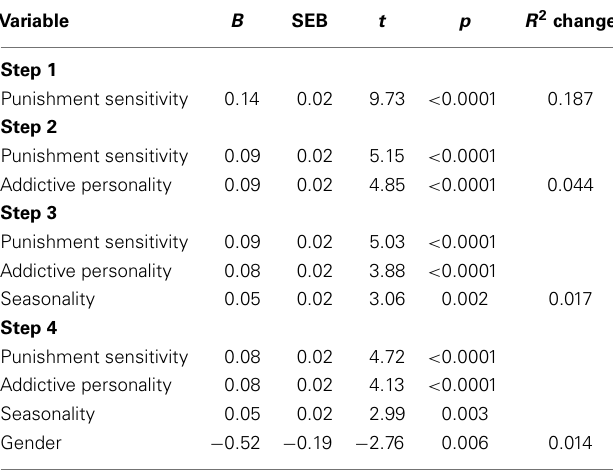
Table 1 | Hierarchical regression analysis summary ( n = 412) for the independent variables (punishment sensitivity, addictive personality, seasonality, and gender) predicting the dependent variable (binge-eating symptom